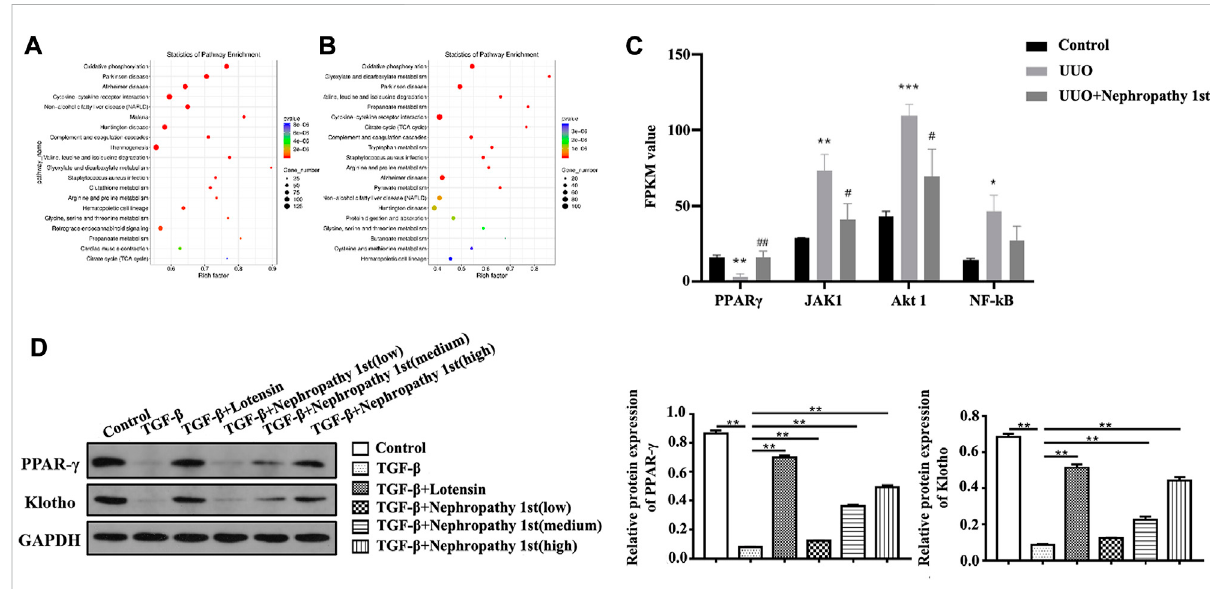
RNA-seq analyze the effect of Nephropathy 1st on PPAR γ expression. The scatter diagram shows the KEGG enrichment analysis of different genes between control vs. UUO (A) and the UUO vs. Nephropathy 1st (B) group. The expression of different genes from the pathway of oxidative